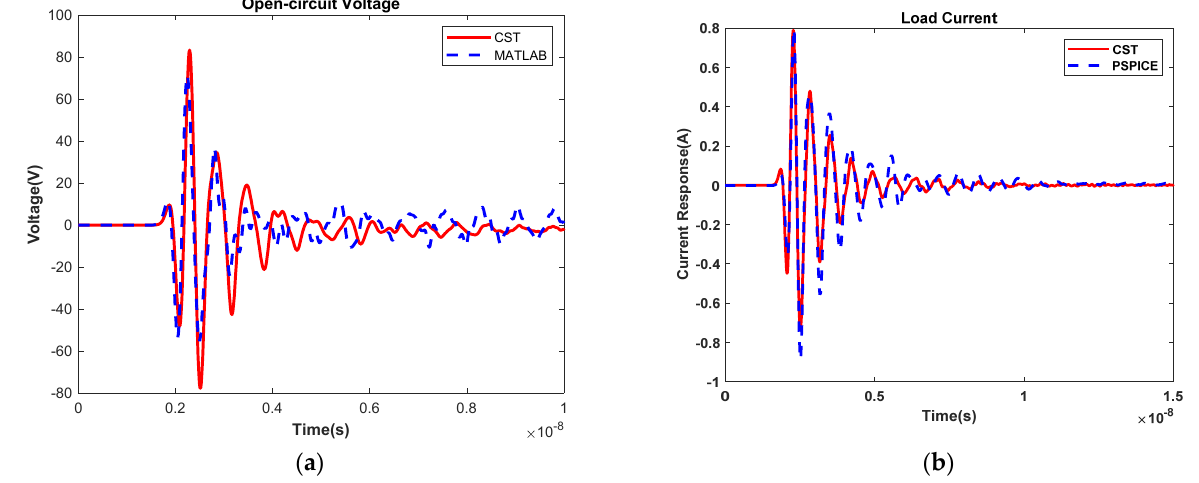
Figure 12. Validation of Norton SPICE model: ( a ) OC voltage; ( b ) Load current.